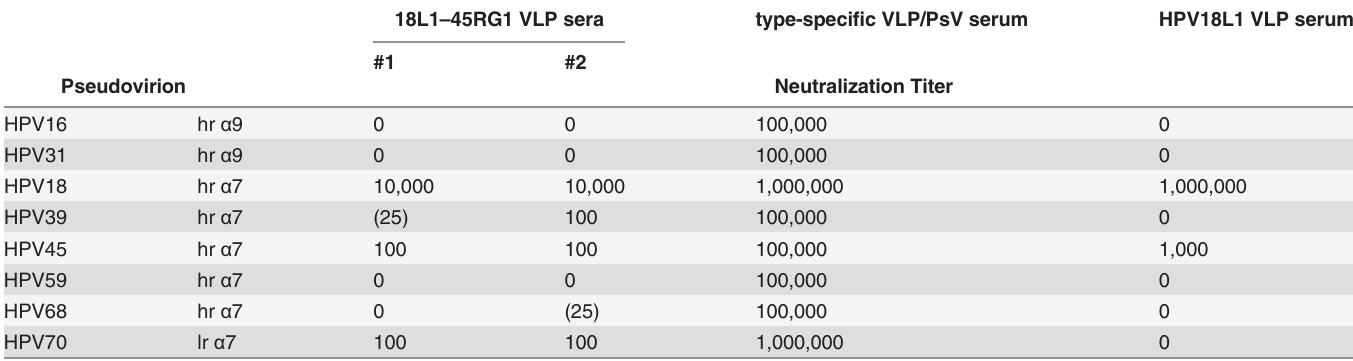
Table 1. In vitro cross-neutralization of α 7 mucosal hr and lr HPV by antisera raised against 18L1 – 45RG1 VLP using L1-based pseudovirion neutralization